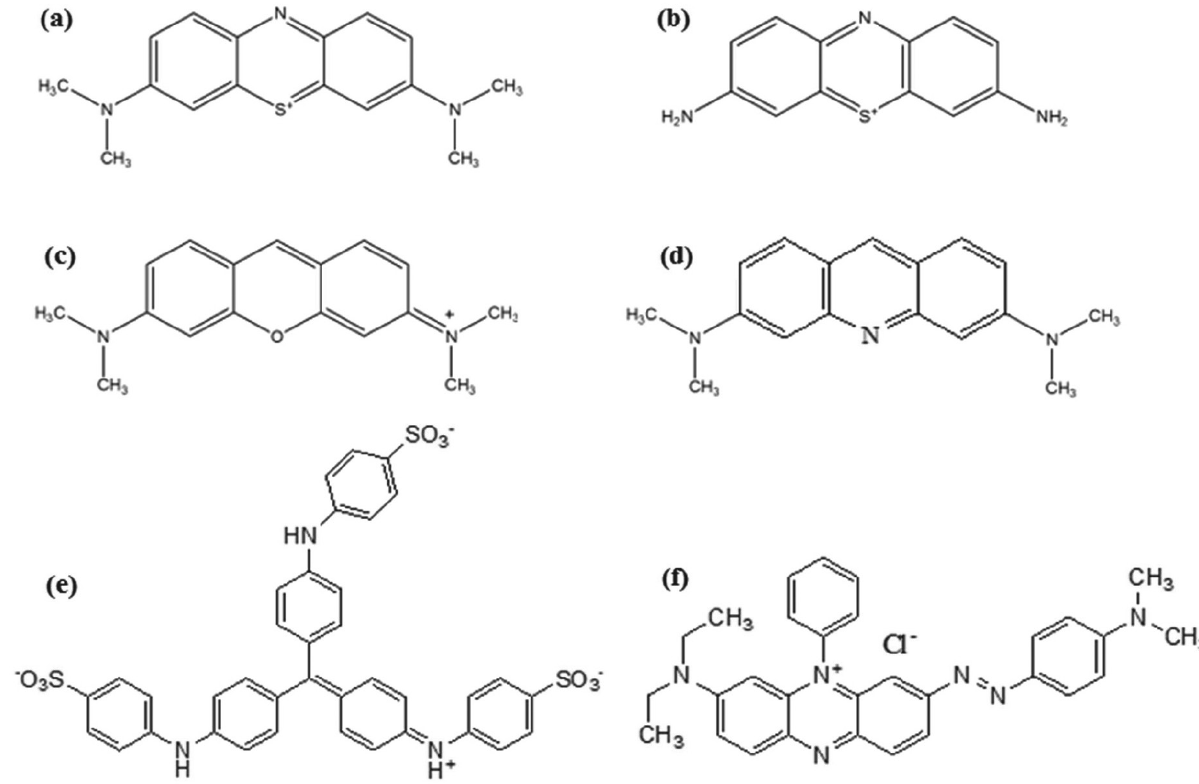
Figure 13. Molecular structure of (a) MB, (b) Th, (c) PY, (d) AO, (e) MEB and (f)